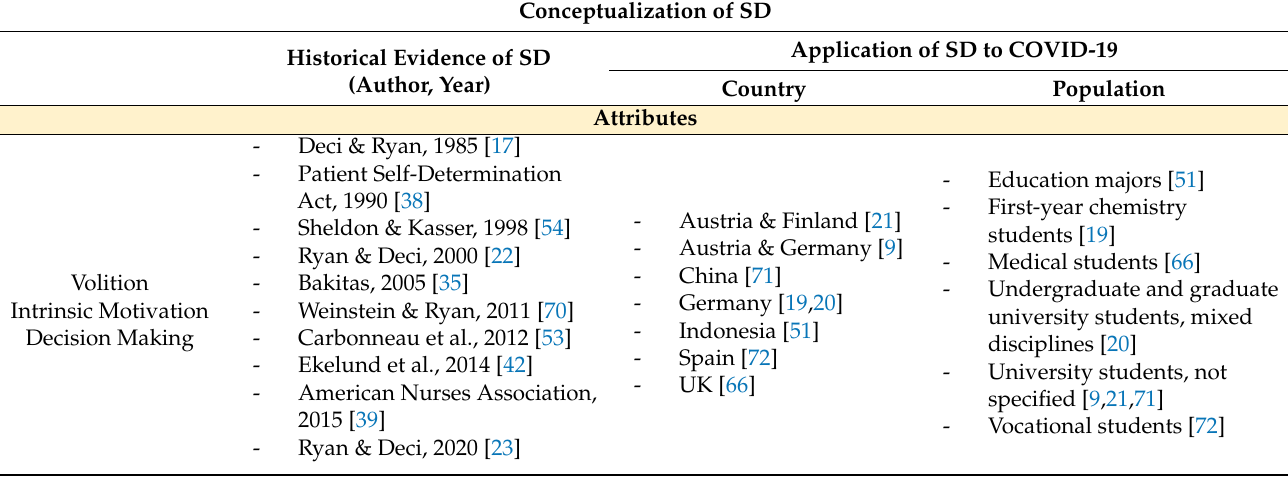
Table 1. Self-Determination (SD) in postsecondary